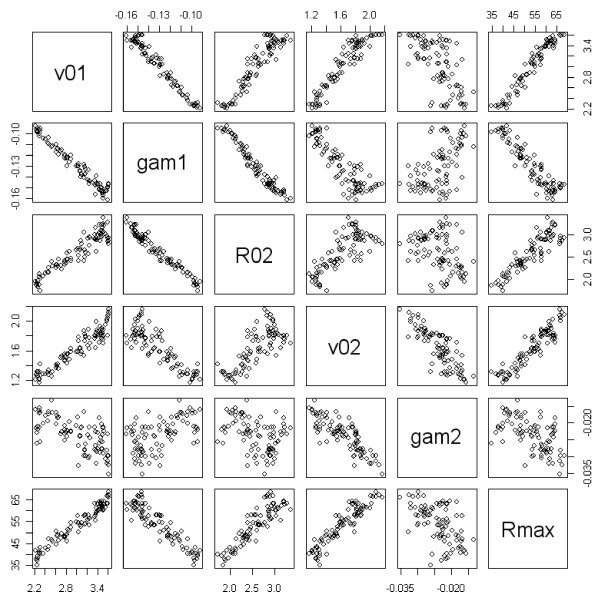
Correlation of the six calculated responses: initial velocities ν01 and ν02, accelerations γ1 and γ2, intermediary yield R02 and final yield Rf.